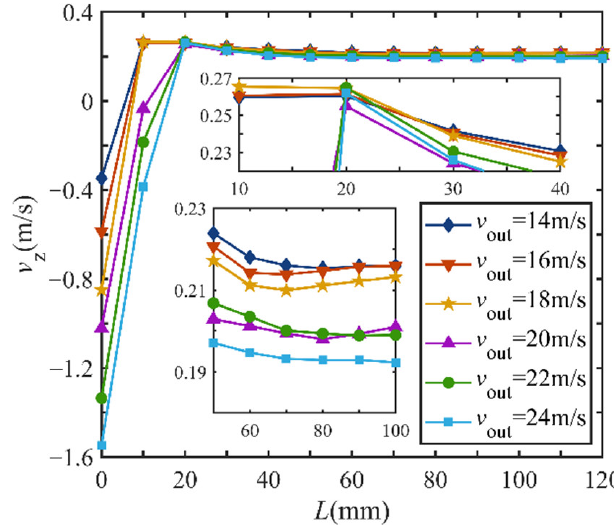
Figure 6. Variation curves of v z with L for different v out .